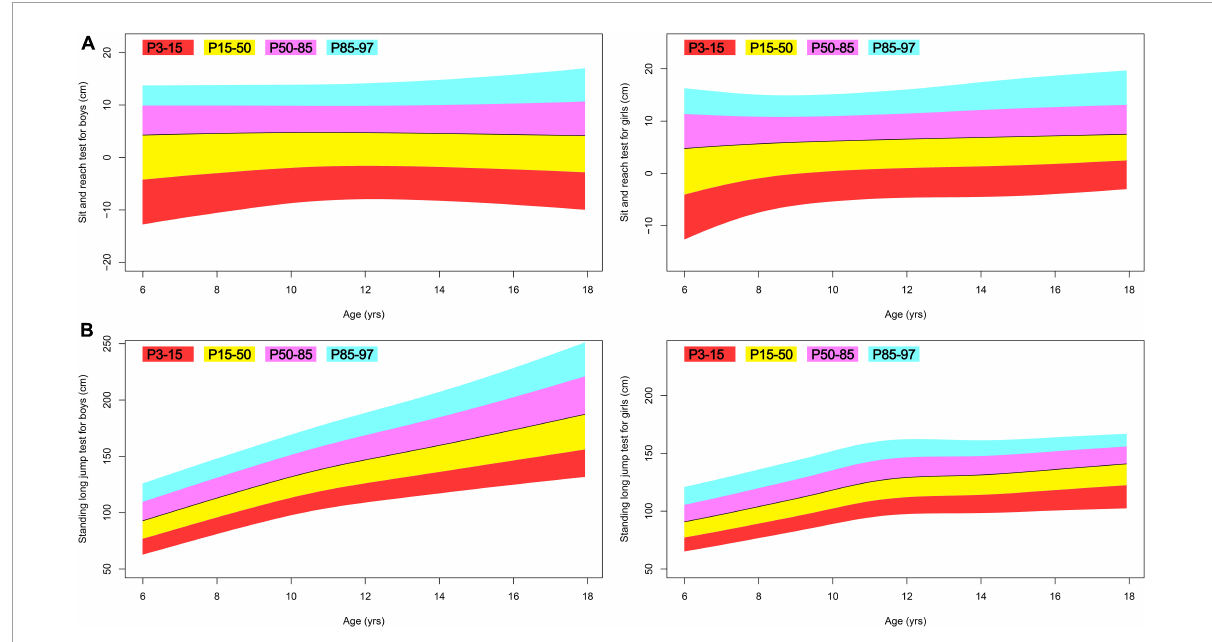
FIGURE5 Fan plot displaying the 3, 15, 50, 85, and 97% centiles for the physical fitness of Tibetan ethnic children aged 6–17. (A) Sit and reach test; (B) standing long jump